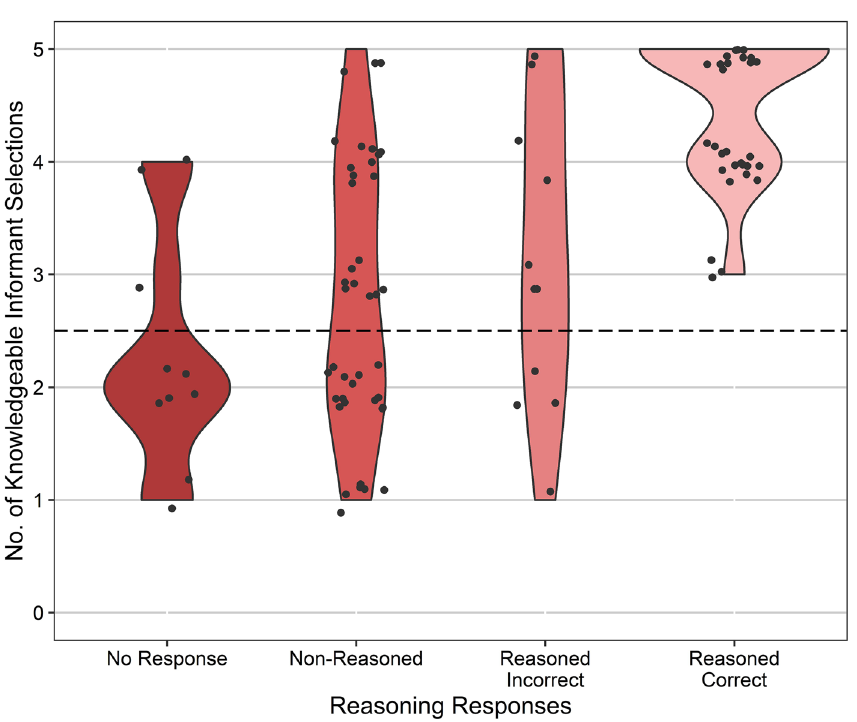
Figure 4. Number of knowledgeable informant selections by category of explicit verbal reasoning response. Children who were categorised as having provided a reasoned correct response were also more likely to have selected the knowledgeable informant in more switch trials. Points show individual participants’ performance. Dashed line indicates chance